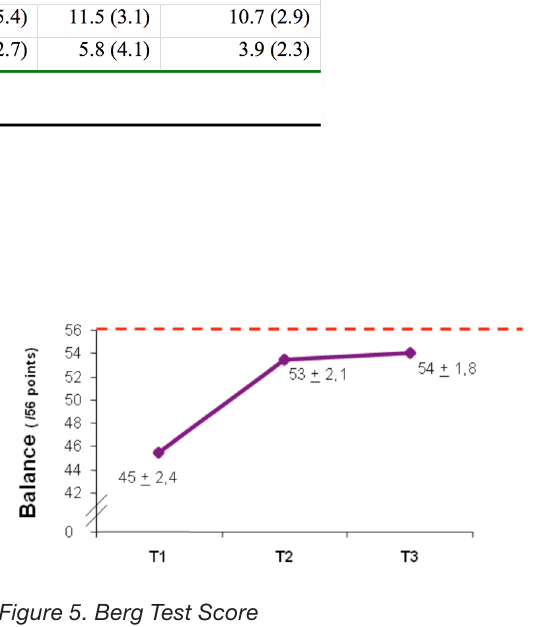
Figure 3. Active Knee Range of Motion